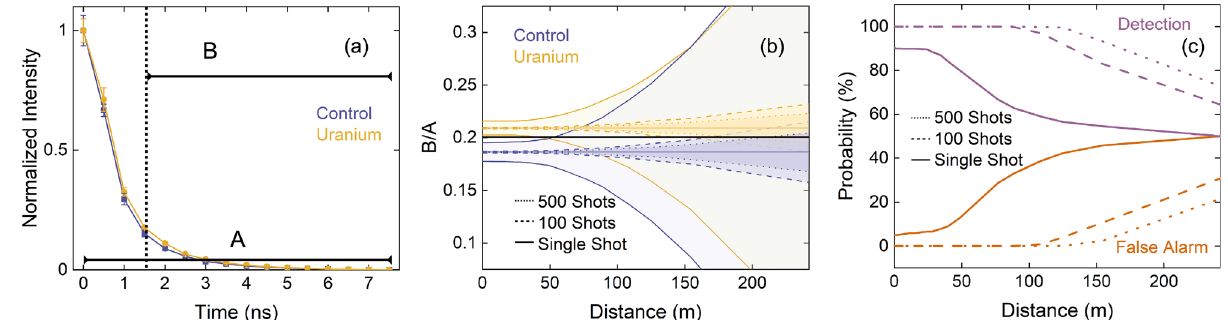
Figure 7. ( a ) Mean temporal profiles for the four control and four U-exposed algae samples, where the error bars represent 1- σ standard deviation in the intensity at that time step. Segment “ B ” begins at 1.5 ns and “ A ” is the integral of the entire time profile. ( b ) B / A calculated from the measured temporal profiles at 0.15 m, and the distance-dependent uncertainties for measurements made with a single shot, 100 shots, and 500 shots. The black horizontal line denotes the critical limit set for determining the detection and false alarm probabilities. ( c ) Detection and false alarm probabilities as a function of distance determined from integrating the Gaussian distributions formed from the B / A and 1- σ uncertainty calculated in ( b